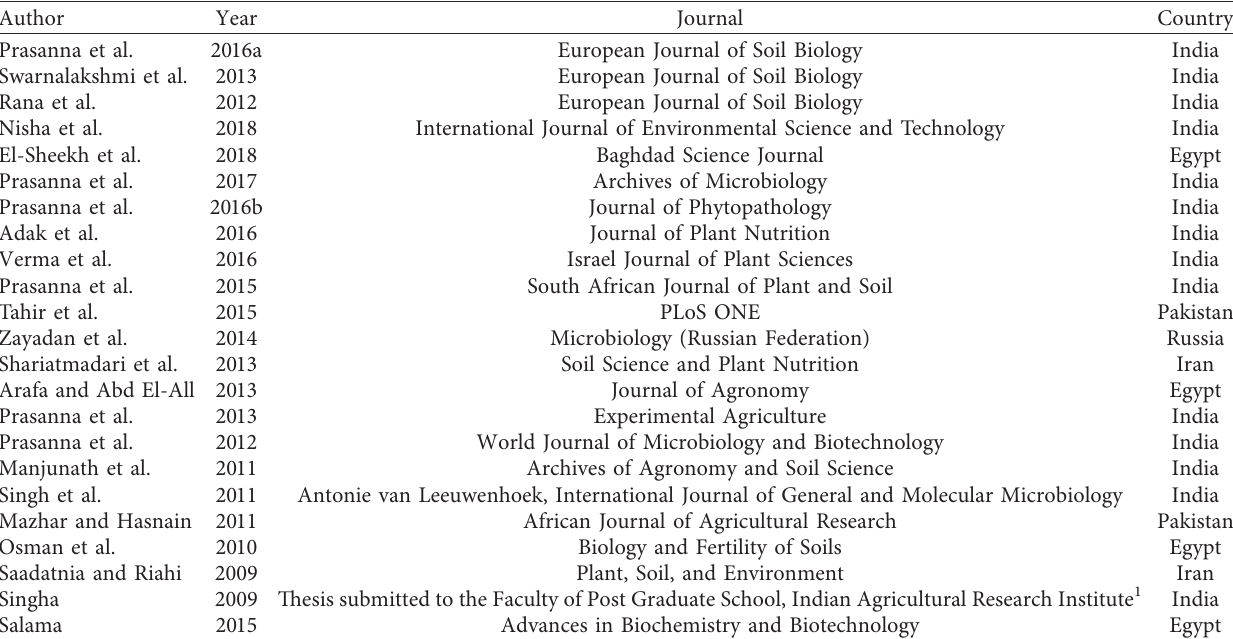
Figure 1: Flowchart representing the search protocol used for the systematic review. Source: Urr´utia and Bonfill, 2010. Table 1: Articles analyzed in this